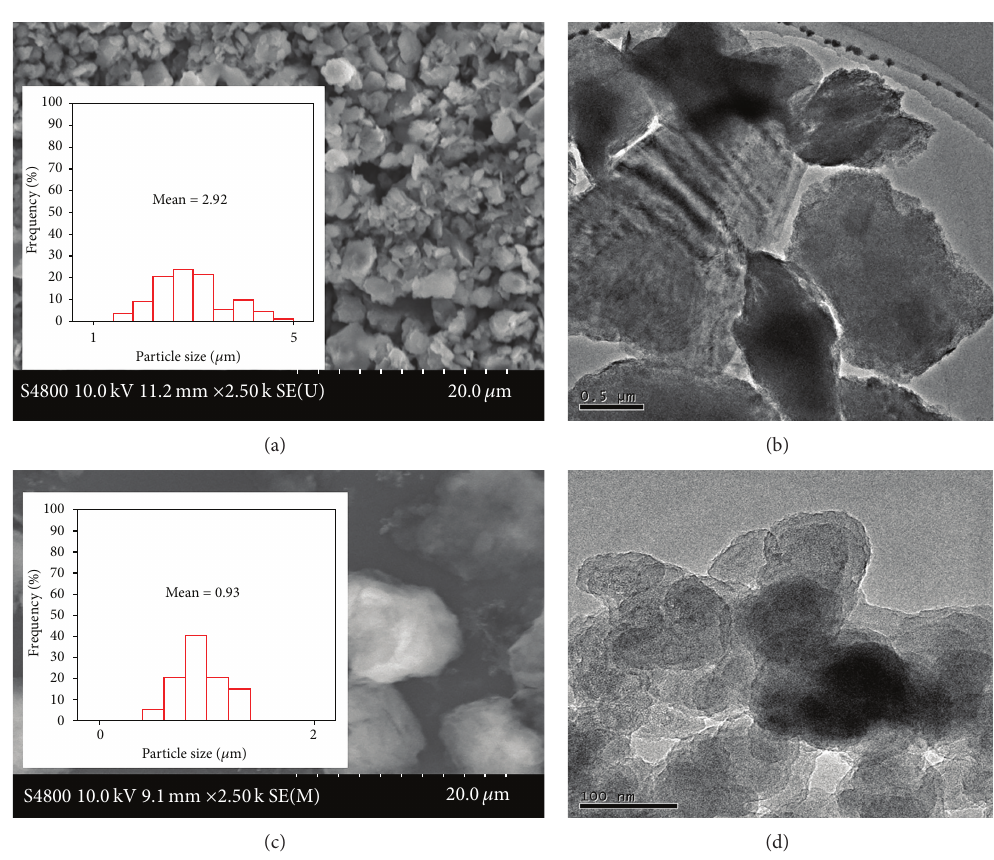
Figure 1: SEM and corresponding TEM images of (a)-(b) as-purchased MMT and (c)-(d) MMT NP. Inset: particle size distributions.